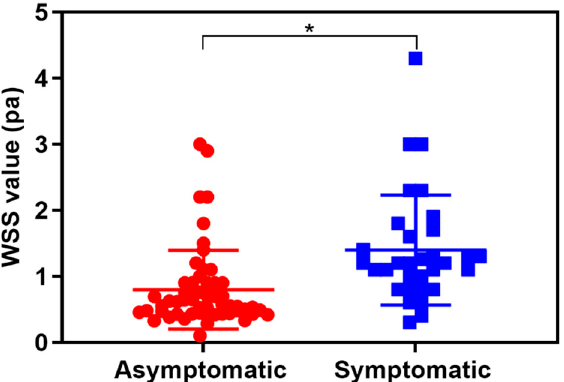
Figure 2. The wall shear stress (WSS) value of the asymptomatic and symptomatic carotid stenosis. * p < 0.05.